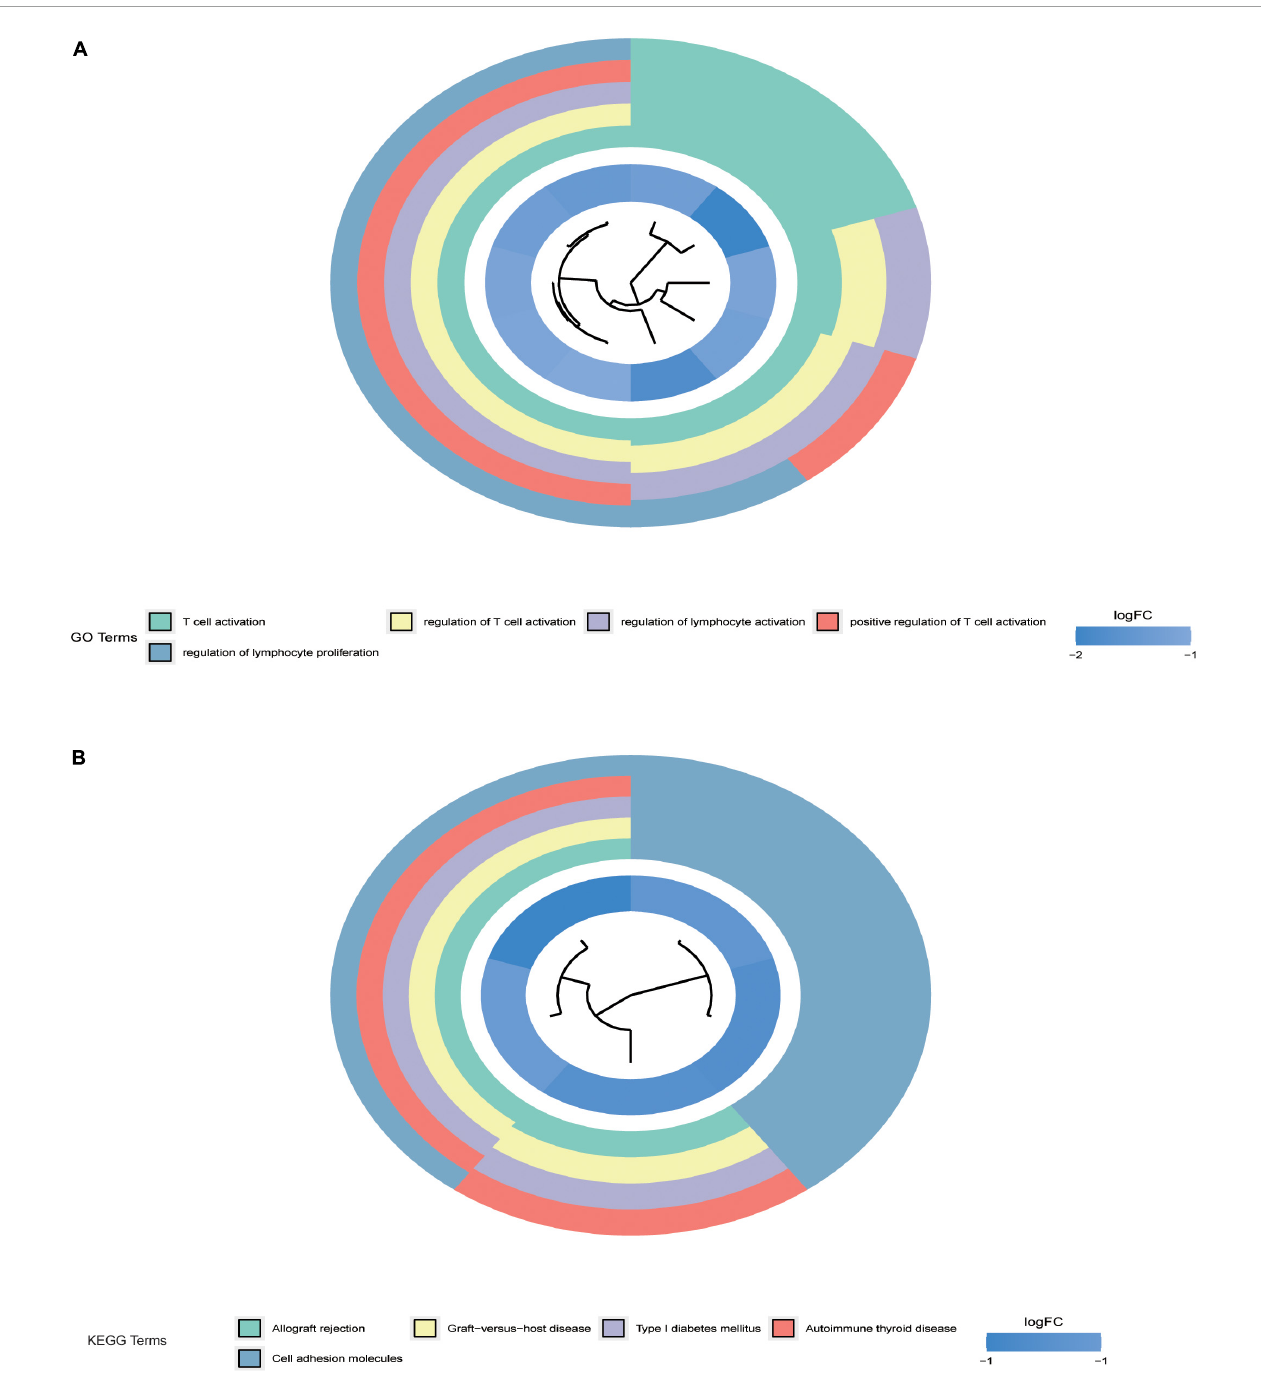
FIGURE2 Gene ontology (GO) and kyoto encyclopedia of genes and genomes (KEGG) enrichment analysis. (A) Shows the enrichment results of GO pathway analysis of differential genes. (B) Shows the enrichment results of KEGG pathway analysis of differential genes. P < 0.05 indicated that the enrichment pathway was statistically